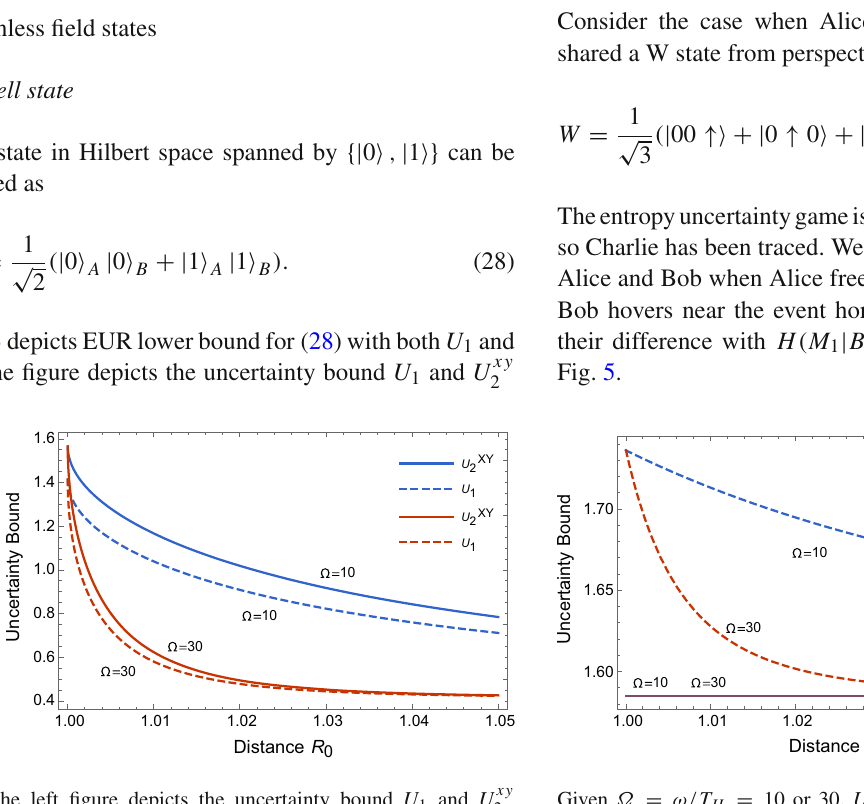
Given Ω = ω/ T H = 10 or 30, U xy 2 different Ω and R 0 , Δ 2 is constant while Δ 1 decreases as Ω and R 0 . 2